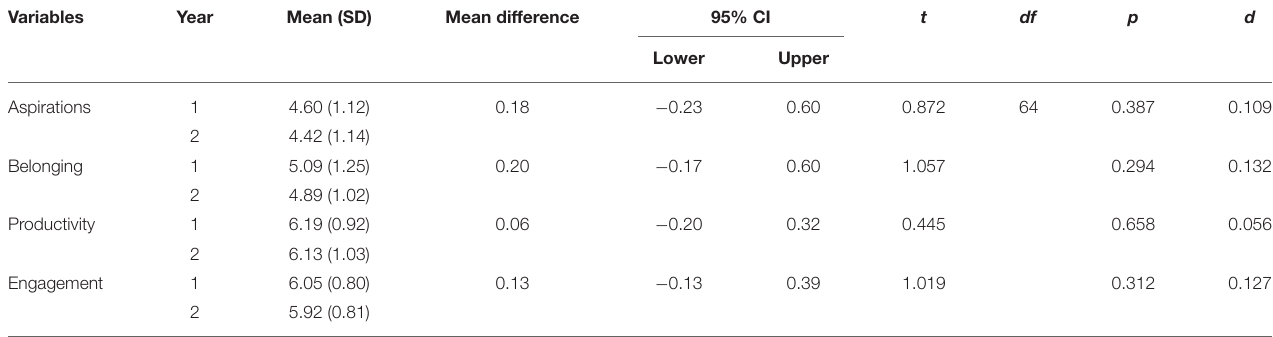
TABLE 3 | Descriptive statistics and t -test results for specialist students’ school engagement.